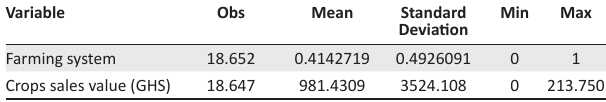
TABLE 5: Farming system and crops sales value.